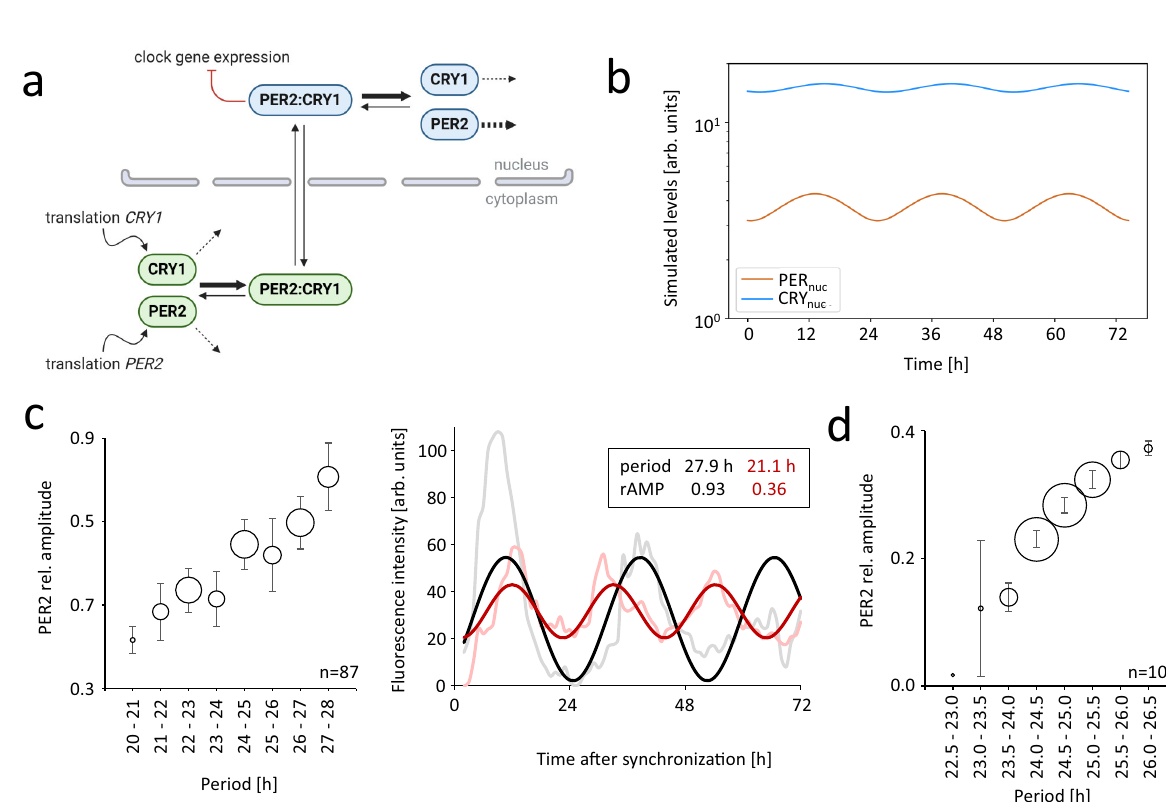
Fig. 5 A mathematical model of nuclear PER2 and CRY1 dynamics in mammalian circadian clock cells reproduces experimental fi ndings. a Model of the PER2:CRY1 loop together with the predictions regarding half-lives and association/dissociation events that arise from our simulations (see main text). Dashed black lines represent degradation events; thicker arrows represent reactions that are predicted to occur at a higher rate. The red solid arrow depicts the inhibition of clock gene expression, exerted solely by the PER2:CRY1 nuclear complex. For a full reasoning of the model design and parameter choice, see Supplementary Note 2 and Supplementary Fig. 9. b The model exhibits sustained 24.7 h oscillations with nuclear PER2 preceding CRY1 rhythms, and with PER2 oscillating with a higher amplitude and lower magnitude than CRY1, thus reproducing experimental results. The parameter set is given in Supplementary Tab. 7. c The amplitude of PER2 rhythms increases with period in knock-in cells with signi fi cantly rhythmic oscillations (n = 87 cells, left). Exemplary raw time series and corresponding cosine fi ts (right) illustrate that long-period rhythms typically display larger amplitudes. The size of the circles depict the number of cells that fall in each bin. Error bars represent SEM. d Our mathematical model reproduces the positive correlation of PER2 amplitude and period. We simulated n = 100 “ arti fi cial ” cells by randomly varying all transcription, translation, degradation, nuclear import and export rates. Parameter values were drawn from a uniform distribution on the interval given by the default parameter value ± 10% (see Supplementary Note 2 for simulation details). The size of the circles depict the number of cells that fall in each bin. Error bars represent SEM. rAMP relative